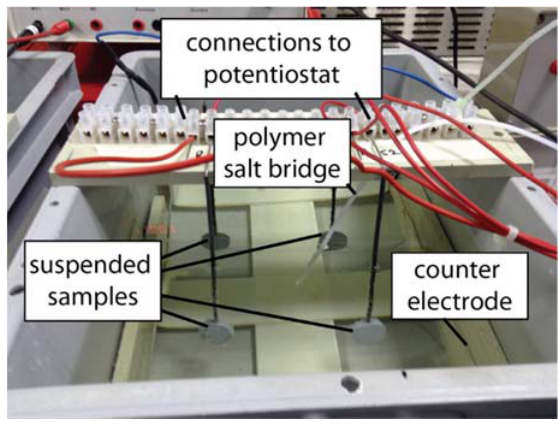
Figure 2. Experimental equipment.